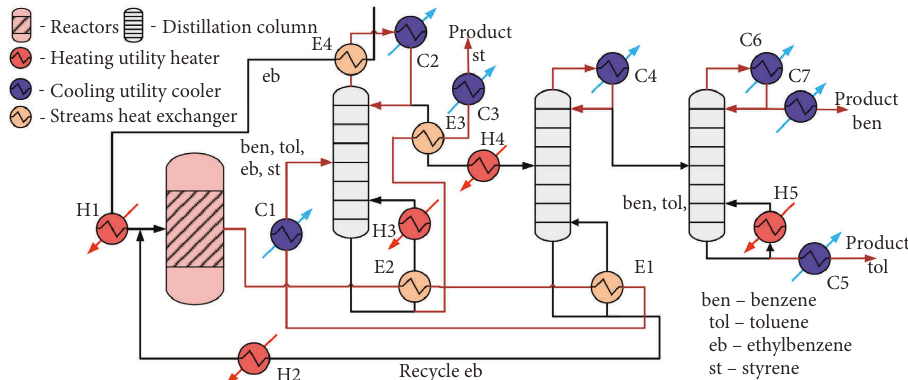
Figure 7: Flowsheet of a heat integrated reaction distillation sequence corresponding to a minimum energy consumption configuration